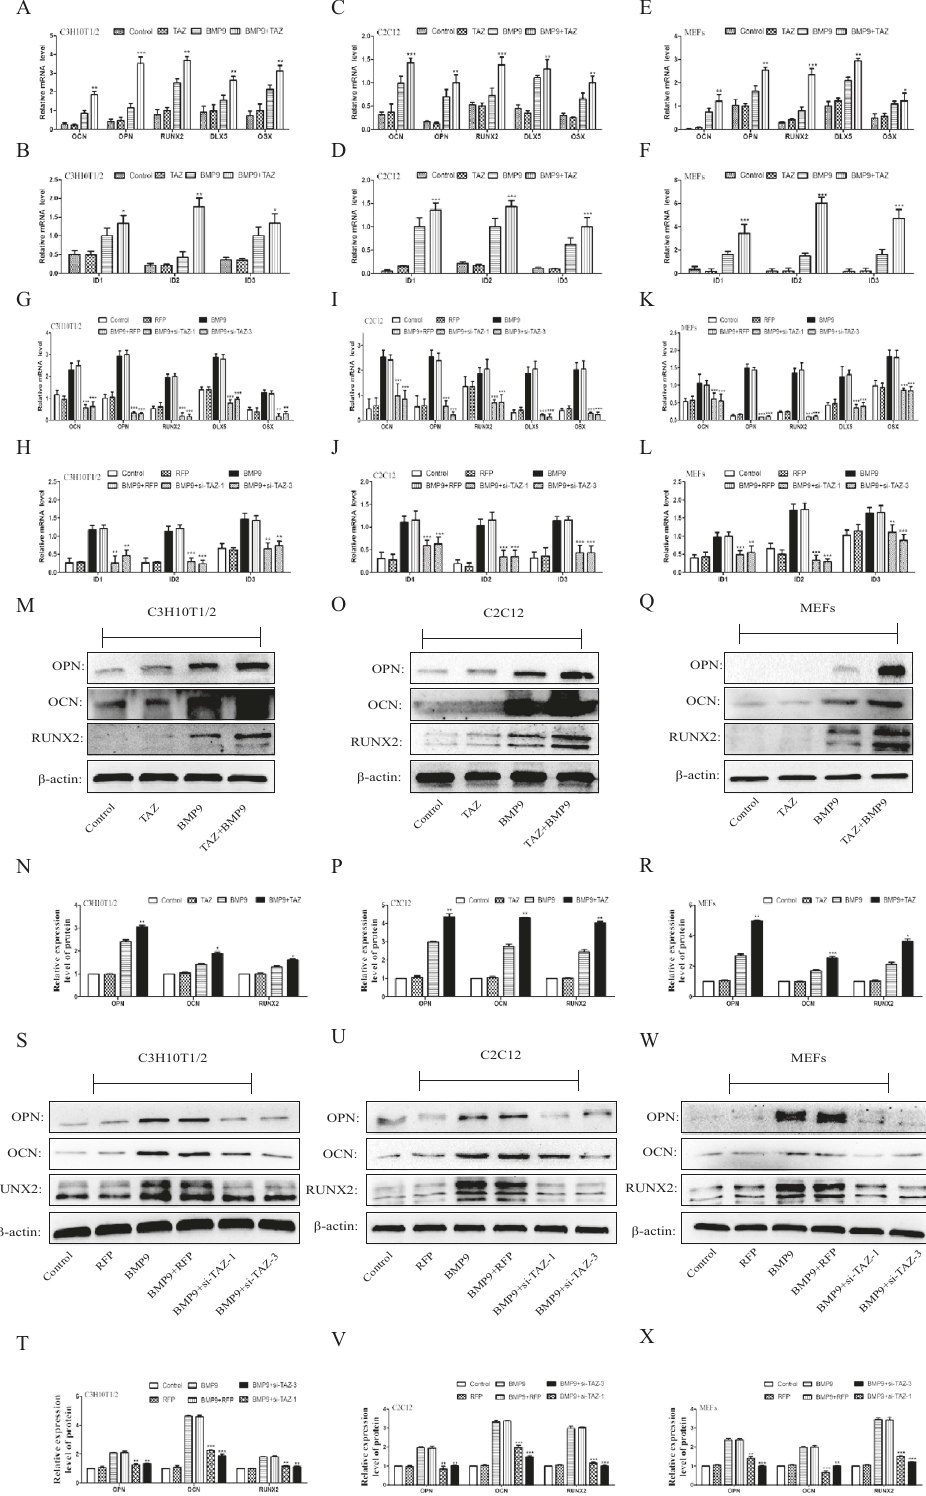
Fig. 3 The effect of TAZ on BMP9-induced expression levels of pivotal osteogenic markers in MSCs and MMCs. Cells were treated with TAZ or si-TAZ, followed by treatment with BMP9. A – L The mRNA expression of RUNX2, OPN, OCN, DLX5, ID1, ID2, and ID3 were determined by qPCR. M – X The protein expression of RUNX2, OPN and OCN were detected by Western blot. The data are shown as mean ± SD for three separated experiments. ( *P < 0.05 , **P < 0.01 , ***P < 0.001) RUNX2 runt-related transcription factor 2, OCN osteocalcin, OPN osteopontin, DLX5 Distal-less homeobox 5, OSX Osterix, ID Inhibitor of differentiation.